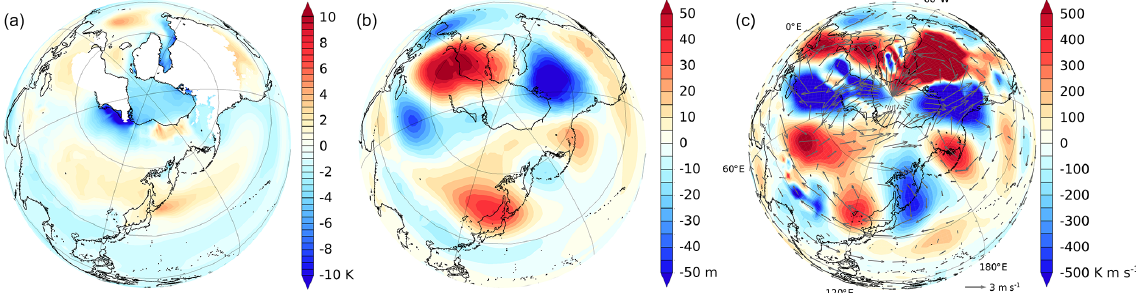
Figure 6. Impact of using different atmospheric models (CAM5 versus CAM4) on simulated LGM climate anomalies during the boreal summer season (JJA). Results are shown as LGM–PI anomalies for LGM_ CAM5_noVeg minus LGM_CAM4_noVeg. (a) Near-surface temperature anomalies (K). (b) 500hPa stationary wave geopotential height anomalies (m; anomalies calculated after subtracting the zonal mean). (c) Vertically averaged meridional sensible heat transport anomalies (Kms − 1 ; shading). Vectors in panel (c) show 500hPa wind anomalies (ms − 1 ). In panel (a) , regions covered by continental ice sheets during the LGM have been masked out. The LGM coastlines are given in